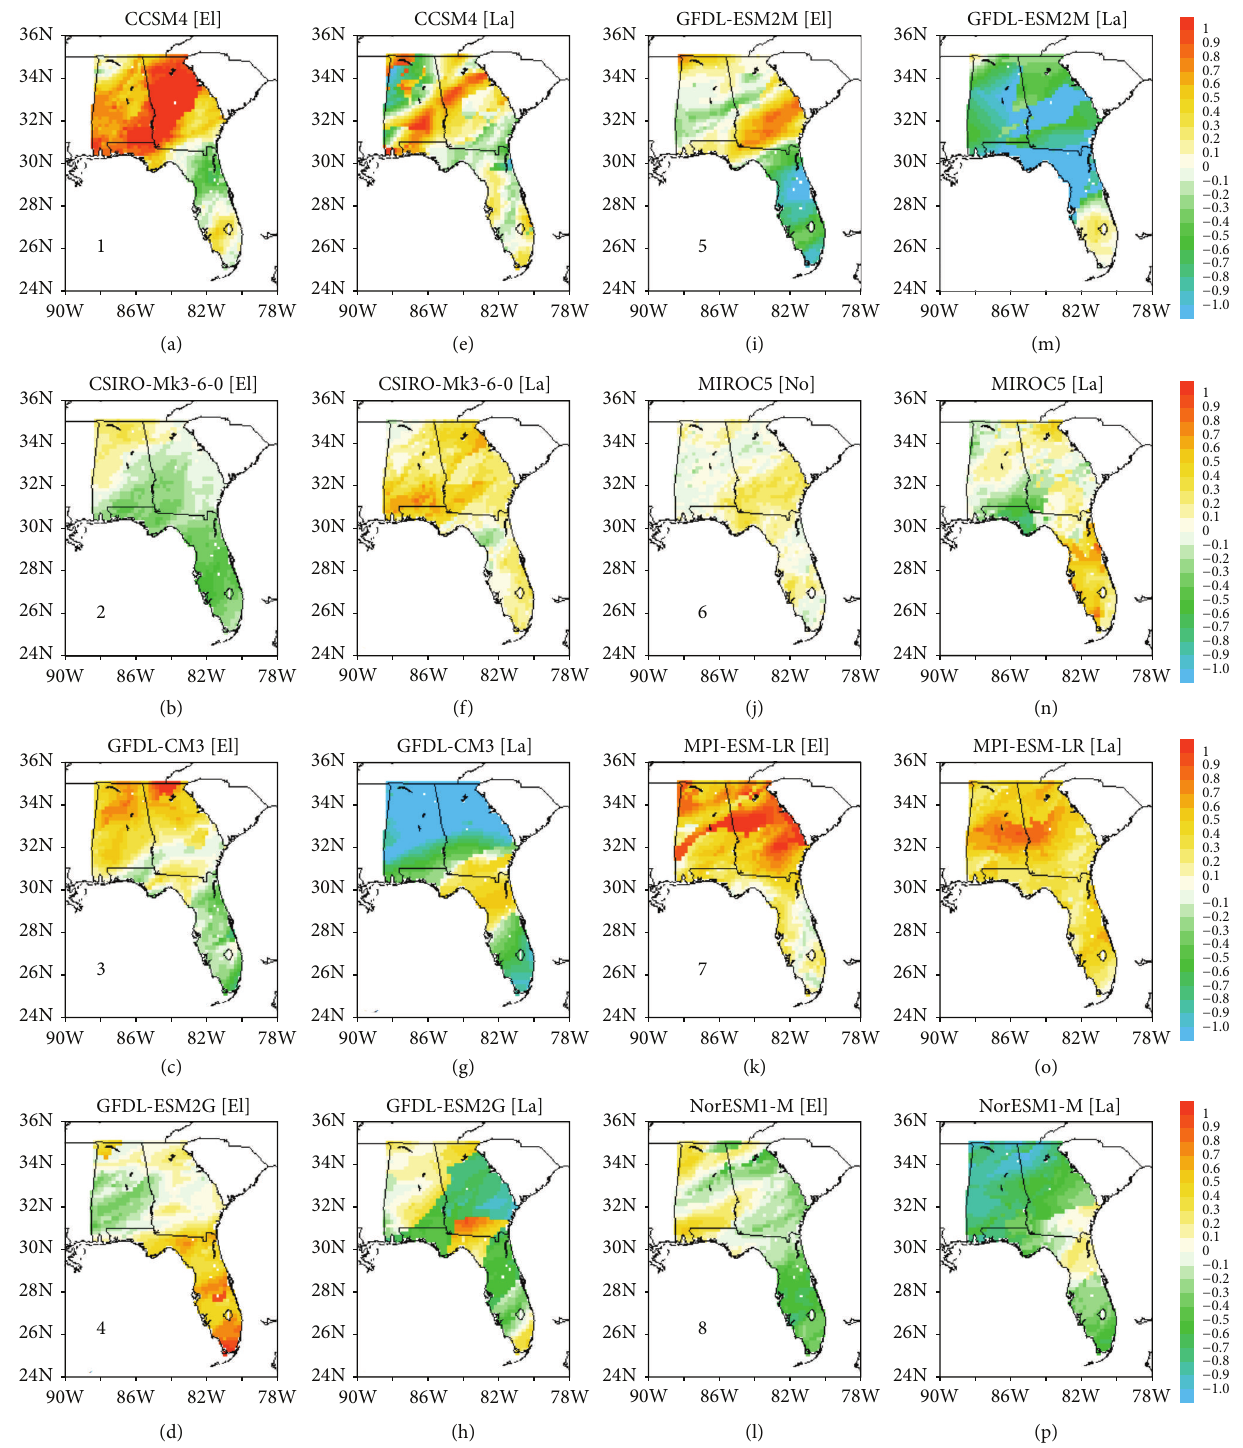
Figure 7: Difference of 75th percentile of DJF mean daily precipitation anomalies (mm/day) between RCP8.5 and historical run for El Ni˜no ((a)–(d) and (i)–(l)) and La Ni˜na ((e)–(h) and